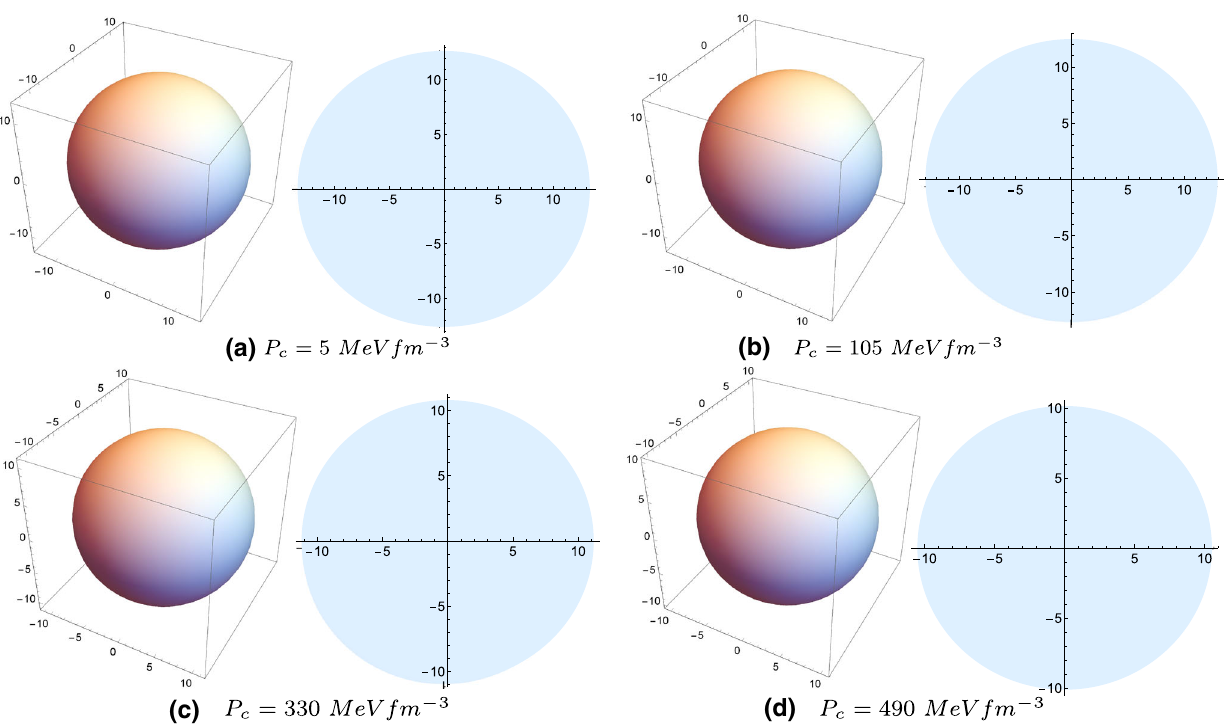
Fig. 4 Illustration of 3- and 2-dimensional deformation of neutron stars in each particular pressure in center at λ BL = 1 . 82. Here we can see, stars with lower pressure in center are more oblate. At Pc = 5 MeV f m − 3 , R p = 12 . 63 km, and R e = 13 . 37 km; at